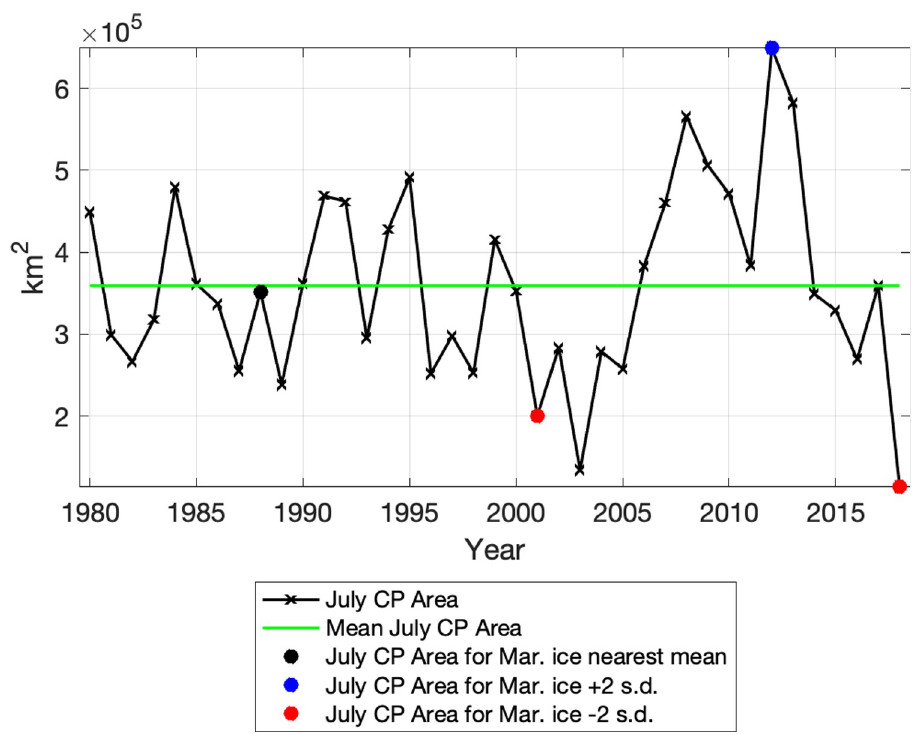
Fig 4. July CP area. July CP area (km 2 ) from RASM for 1980–2018 (black line). Mean July (1980–2018) CP area (km 2 ) green line. The black circle indicates the year (1988) when March ice area was nearest the long-term mean. The blue circle indicates the year (2012) with March ice area 2 standard deviations (s.d.) above the mean. The red circles indicate the years (2001 and 2018) with March ice area 2 s.d. below the mean.